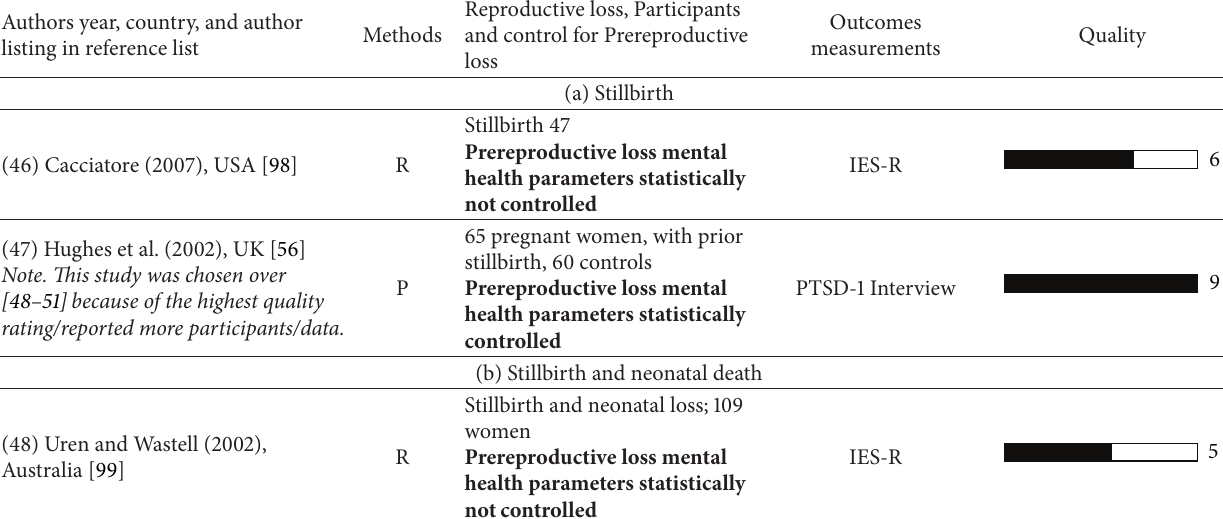
Table 4: Characteristics of included studies for stillbirth (a) and stillbirth with neonatal death (b). Authors year, country, and